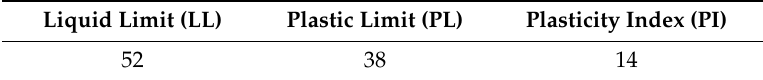
Figure 4. Particle size analysis results of raw acid clay .